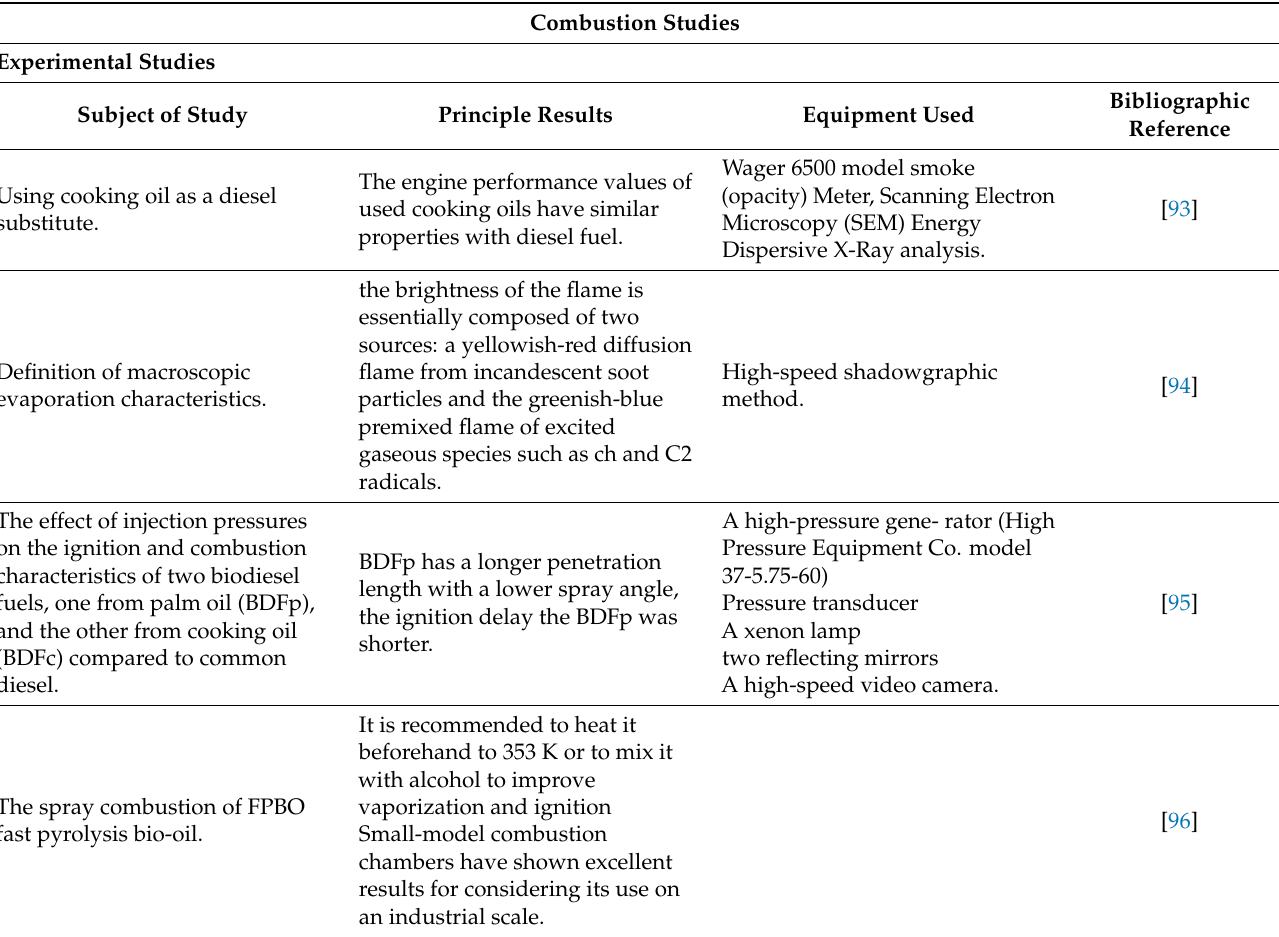
Table 2. List of equipment used and the results obtained in the combustion studies among relevant papers. Combustion